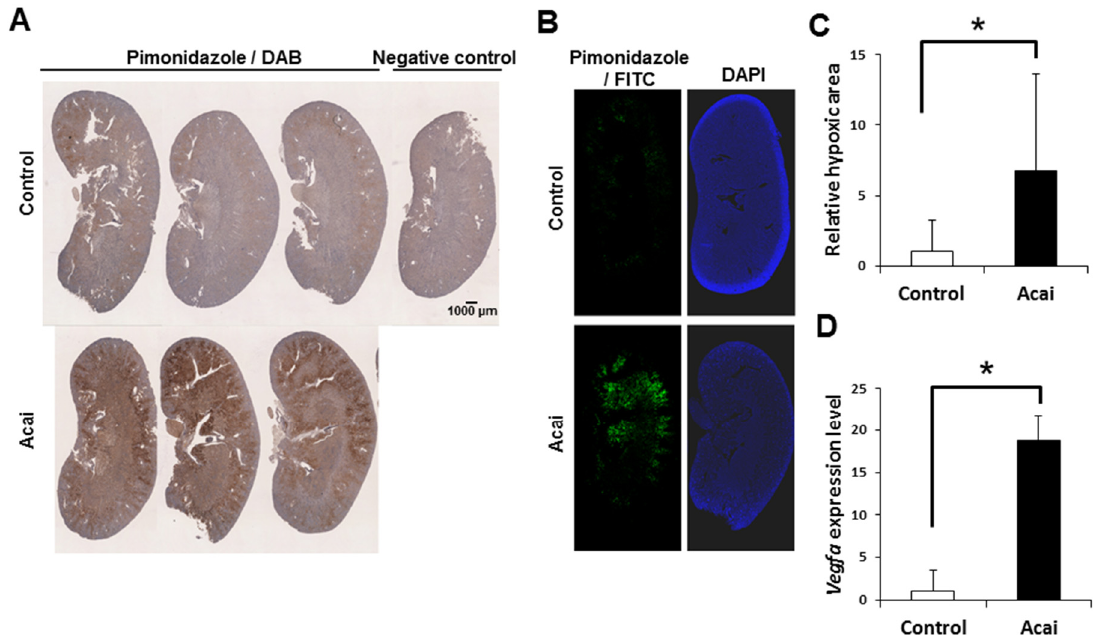
Figure 2. Acai extract induces a hypoxic reaction in kidney. ( A – C ) The pimonidazole-positive hypoxic area in kidney sections 2–3 h after the oral administration of acai extract (10 g/kg) was detected